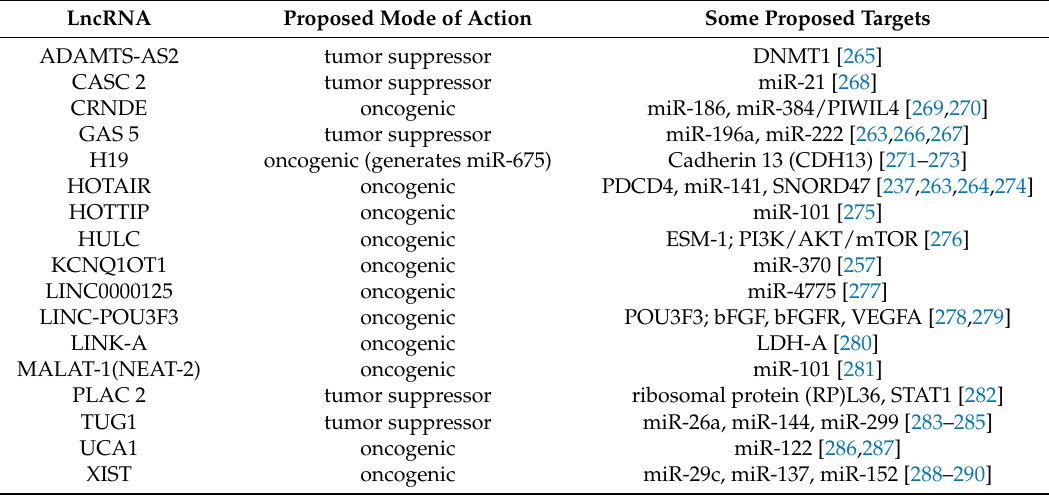
Table 3. Involvement of long non-coding RNAs (LncRNAs) in glioma growth and invasion: putative mode of action of a few LncRNAs, with some of their suggested